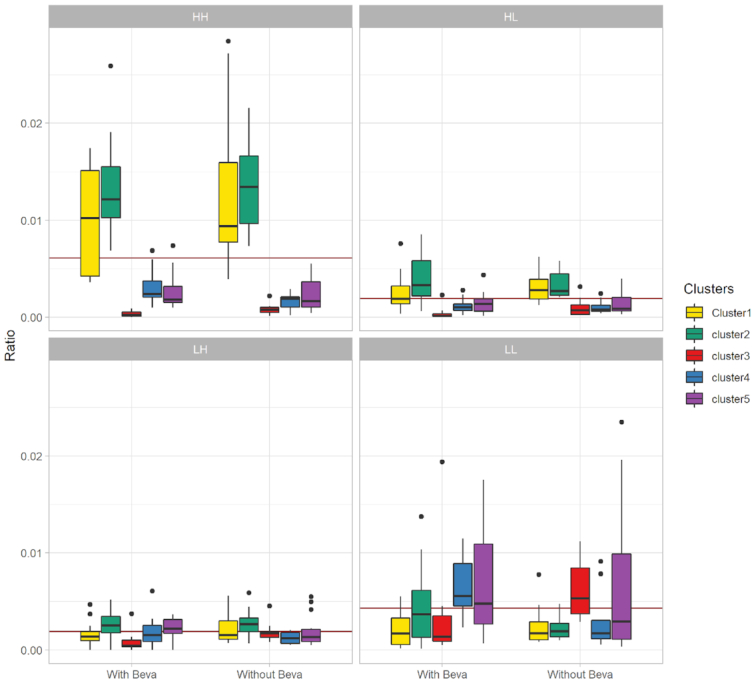
Quantitative analysis to find the association between drug LISA maps and identified clusters from complete A2780–1A9 tumor MSI data. Here, each subplot highlights the fraction of pixels present in different zones of the LISA map under 2 treatment conditions. The red horizontal line in each subplot is a global mean value for pixel ratio for that particular zone. HH: high-high; HL: high-low; LH: low-high; LL: low-low; With Beva: pretreated with bevacizumab; Without Beva: without bevacizumab pretreatment. Clusters: different clusters identified in A2780 tumor MSI data.